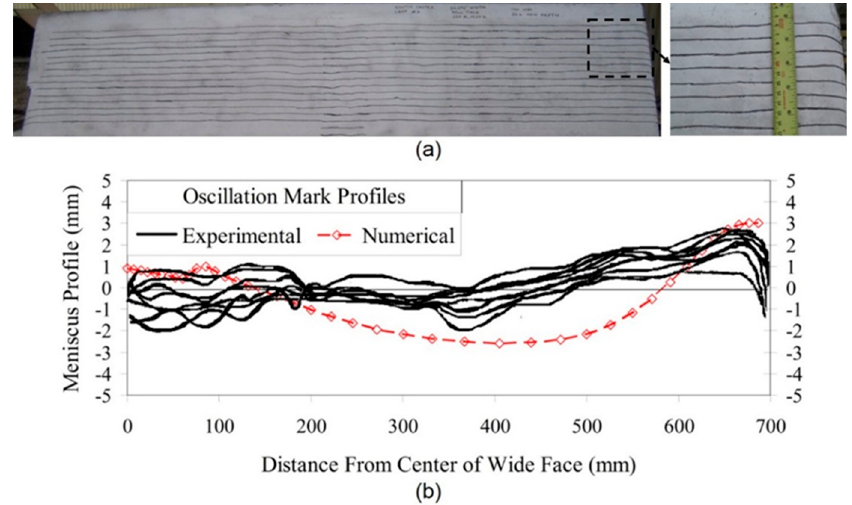
Figure 4. ( a ) Measurements and ( b ) model validation of oscillation mark profiles on steel slab surface [61].